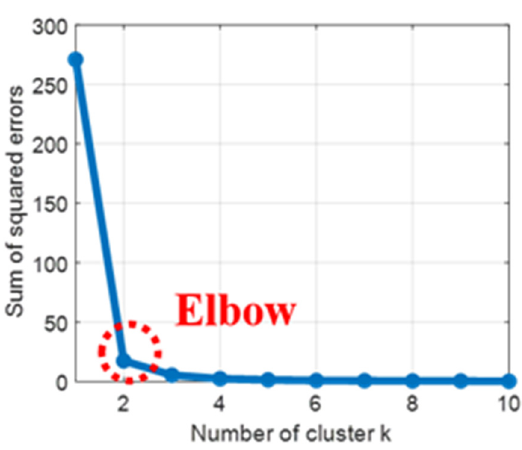
Figure 9. Result of elbow method.